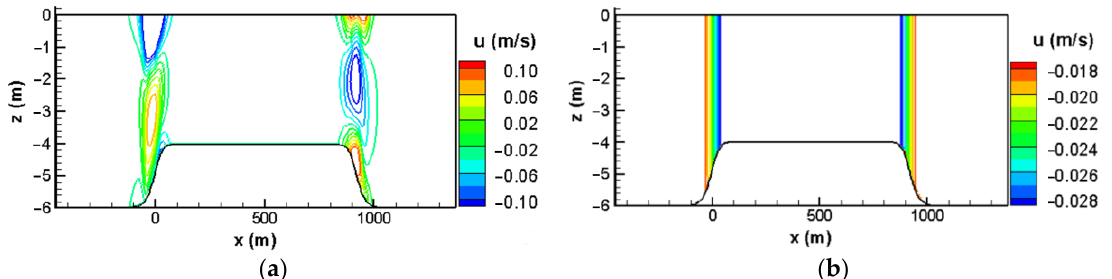
Figure 2. Distribution of quasi-Eulerian mean horizontal velocity. ( a ) Calculated by equations of Walstra, Roelvink [16]. ( b ) Calculated by equations of Nguyen, Jacobsen [5].